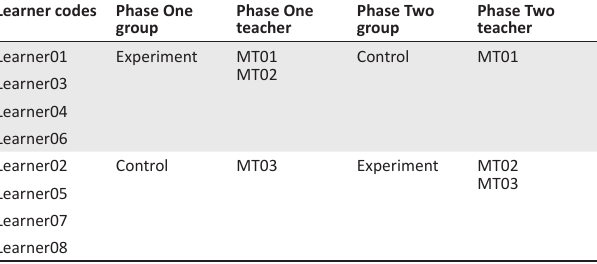
TABLE 1: Allocation of learners and teachers to the experimental and control groups in Phase One (addition and subtraction) and Phase Two (multiplication and